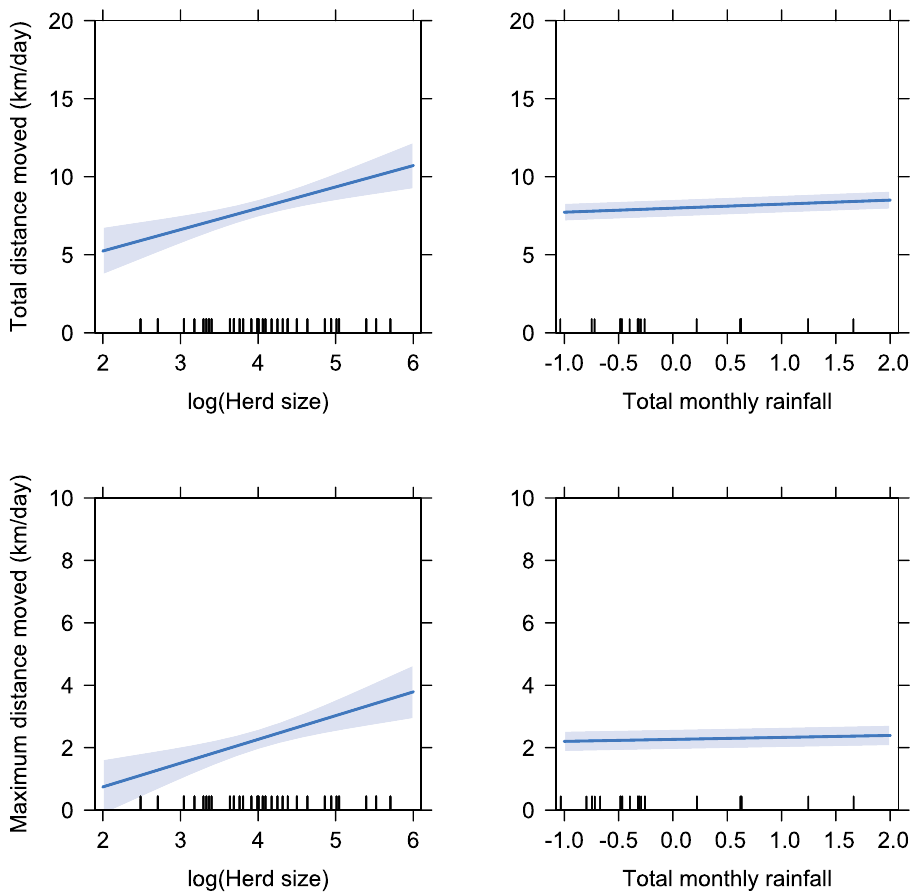
Figure 3. Herd size (log-transformed) and cumulative rainfall in the previous month (scaled and centered) increase the daily movement distance and displacement of cattle. Lines represented predicted effects from the GLMMs. Shaded areas are the 95% confidence